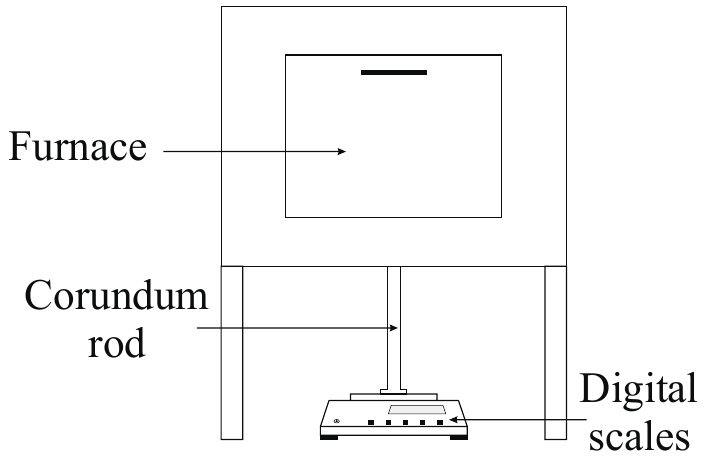
Figure 2. The apparatus used in this study.